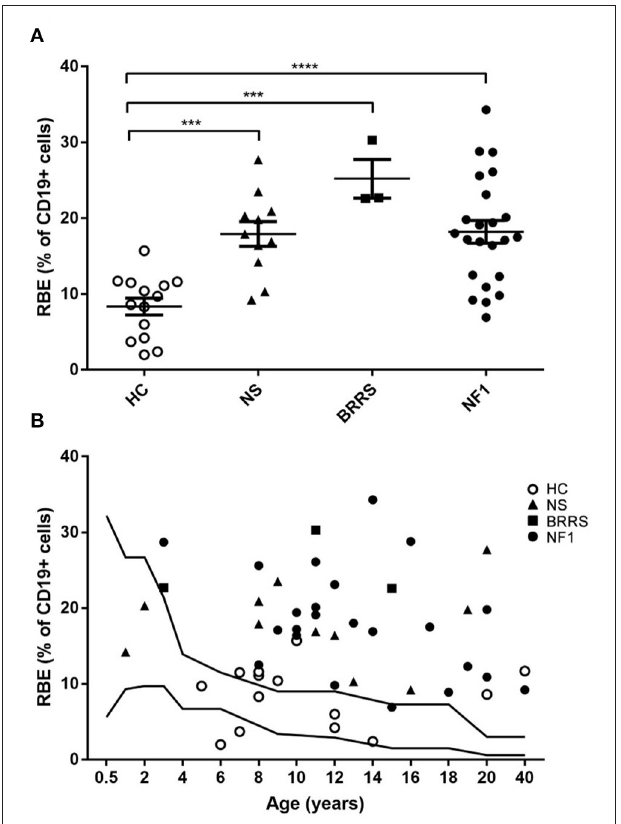
FIGURE 2 | Recent bone marrow emigrants (RBE) values by flow cytometry. (A) RBE expressed as percentage of lymphocytes B (CD19 + cells) grouped according to healthy controls and to the three syndromes evaluated in our cohort. Statistical analysis was performed using one way ANOVA multiple comparisons (Holm-Sidak’s post-test correction); only statistically significant findings are highlighted in figure. *** P < 0.001; **** P < 0.0001. (B) RBE expressed as percentage of lymphocytes B (CD19 + cells) displayed according to age. HC, healthy controls; NS, Noonan syndrome; BRRS,